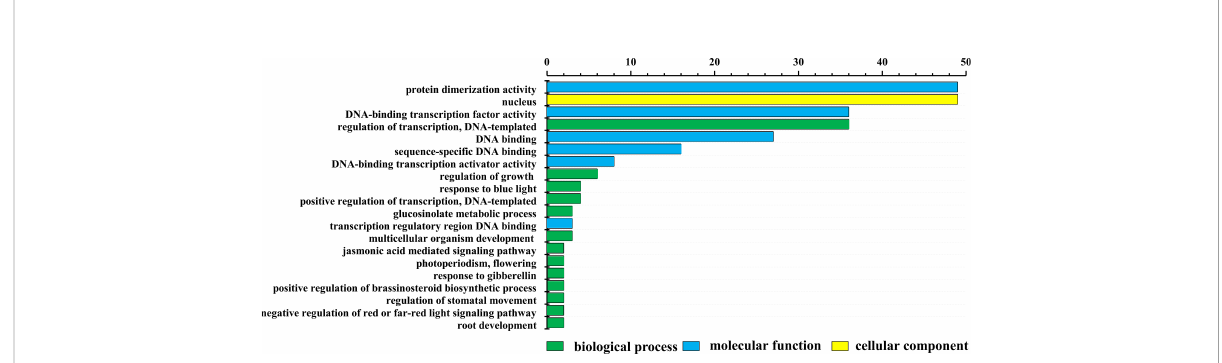
FIGURE 4 Gene ontology (GO) enrichment analysis of LrbHLH proteins. The top 20 GO terms of level 2 in biological process, cellular component, and molecular function were visualized. The X and Y axes represent the enriched protein numbers and the information on GO terms,